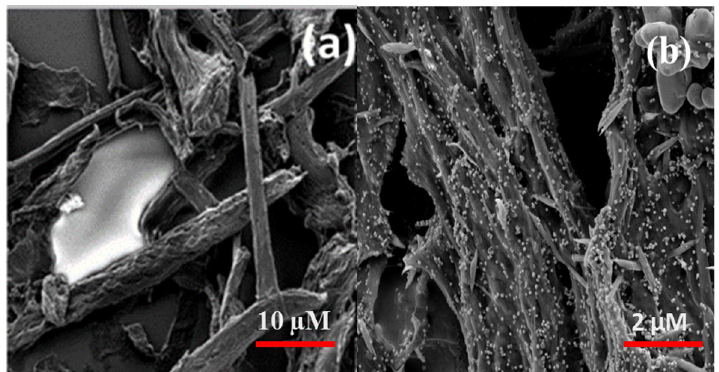
Figure 11. SEM micrographs of ( a ) CNF and ( b ) AgNPs@CNF.